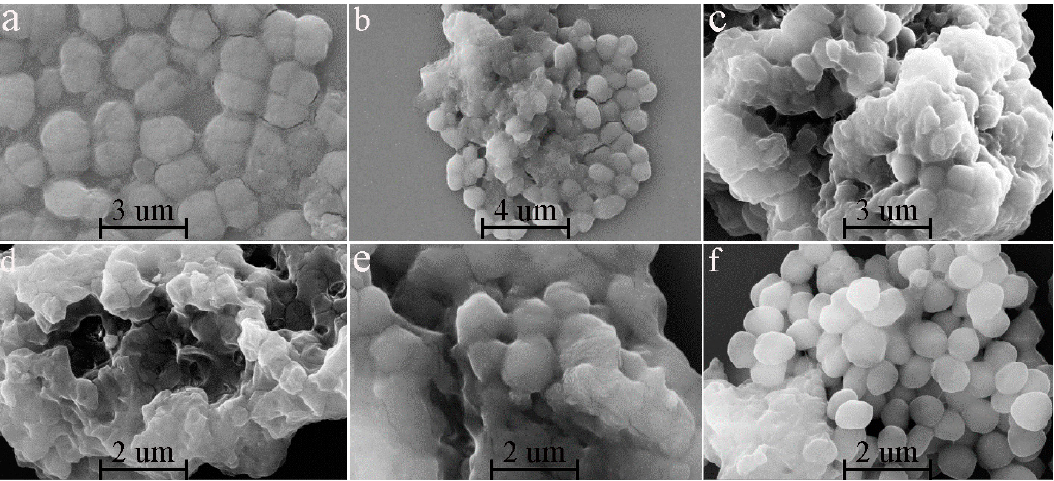
Figure 1. SEM micrographs of the raw and chemically modified biomass. ( a ) Unmodified biomass. ( b ) Extraction of lipid fraction. ( c ) Modification of amino group. ( d ) Modification of carboxyl group. ( e ) Modification of phosphate group. ( f ) Modification of hydroxyl group.